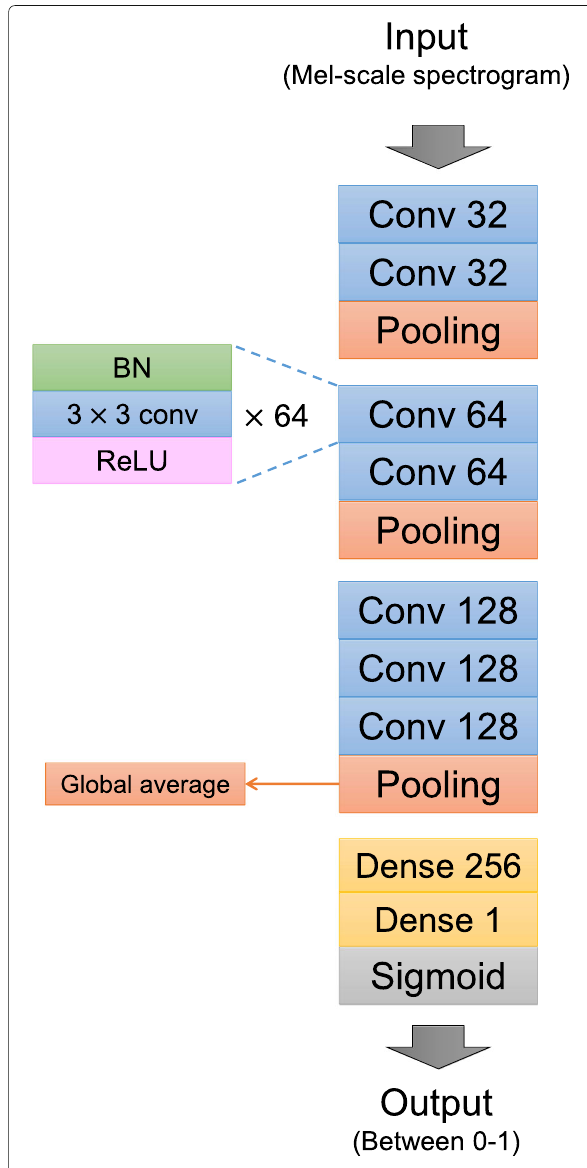
Fig. 2 The architecture of the CNN models used in the proposed degradation detection approach